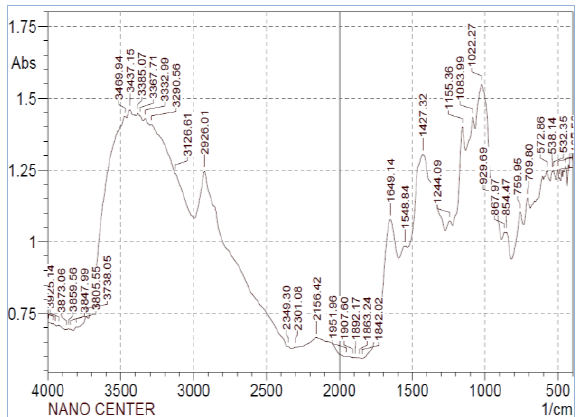
Figure, 2: Show the FTIR of ZnO nanopartical.